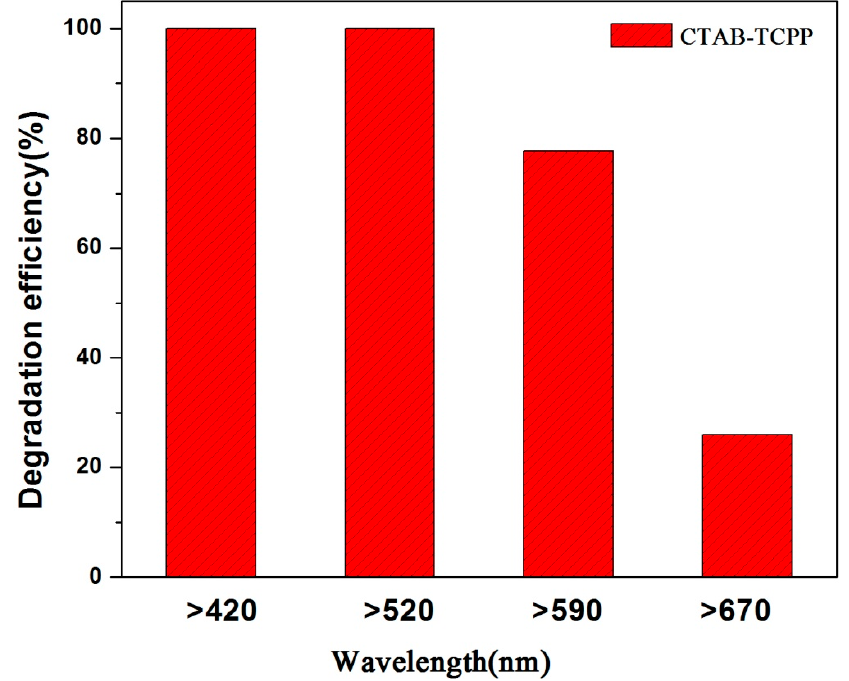
Figure 7. Degradation efficiencies by CTAB-TCPP under different wavelength ranges of light.